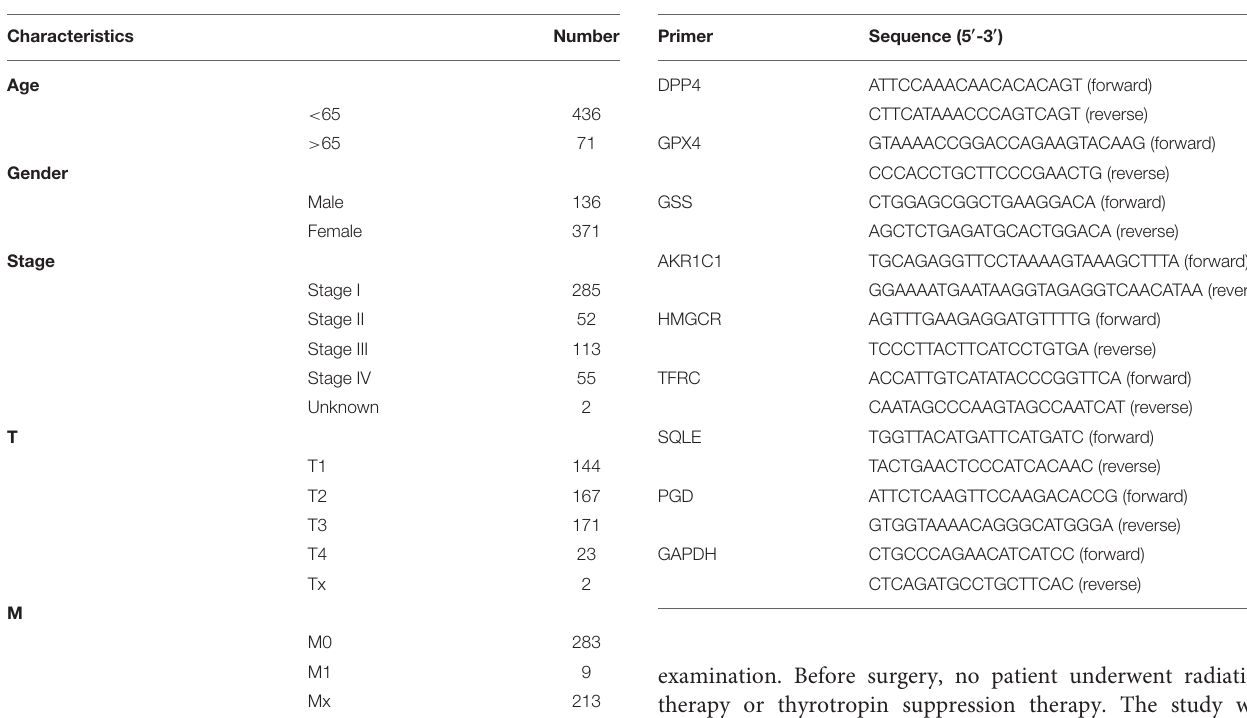
TABLE 2 | Primer sequences for